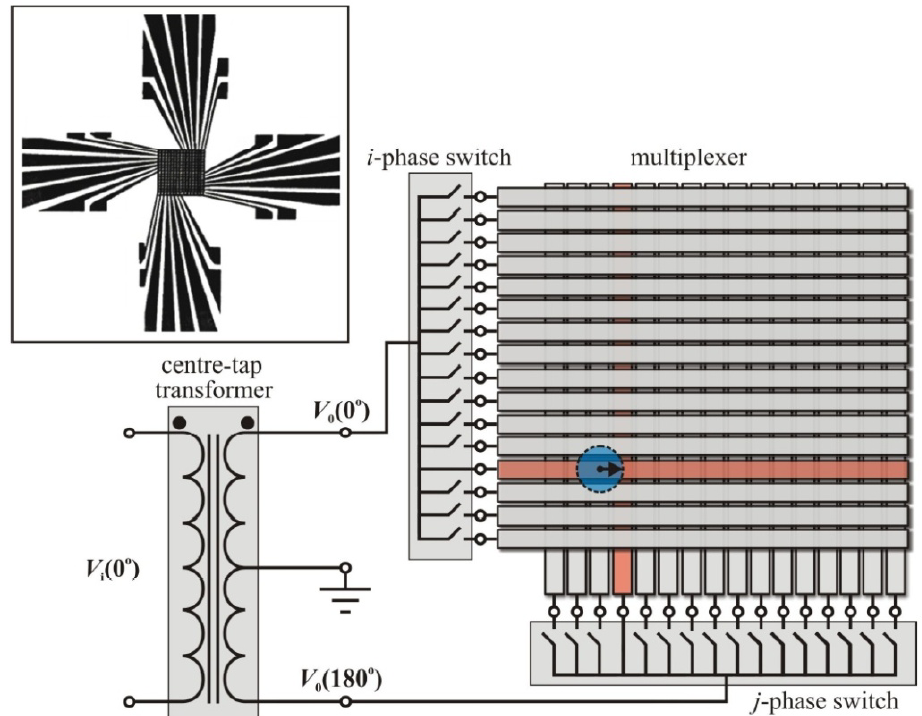
Figure 3. The digital microfluidic multiplexer schematic is shown. A voltage V applied to the centre-tap transformer input; the V phase-switched onto the multiplexer electrodes. A photo of the overlapped and orthogonal upper row and lower column electrode plates is shown in the top left